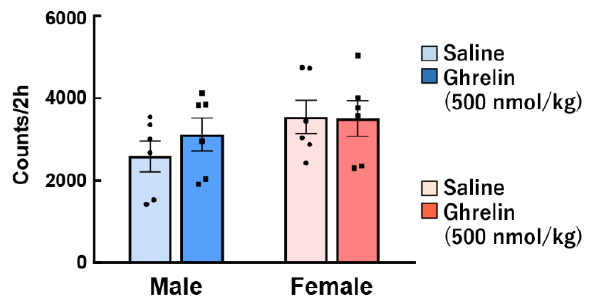
Figure 2. Effect of ghrelin on voluntary movements in male and female mice. Ghrelin (500 nmol/kg) was intraperitoneally administered to ad libitum-fed mice at the start of the dark period, and then the total locomotor activity over 2 h was evaluated. n =